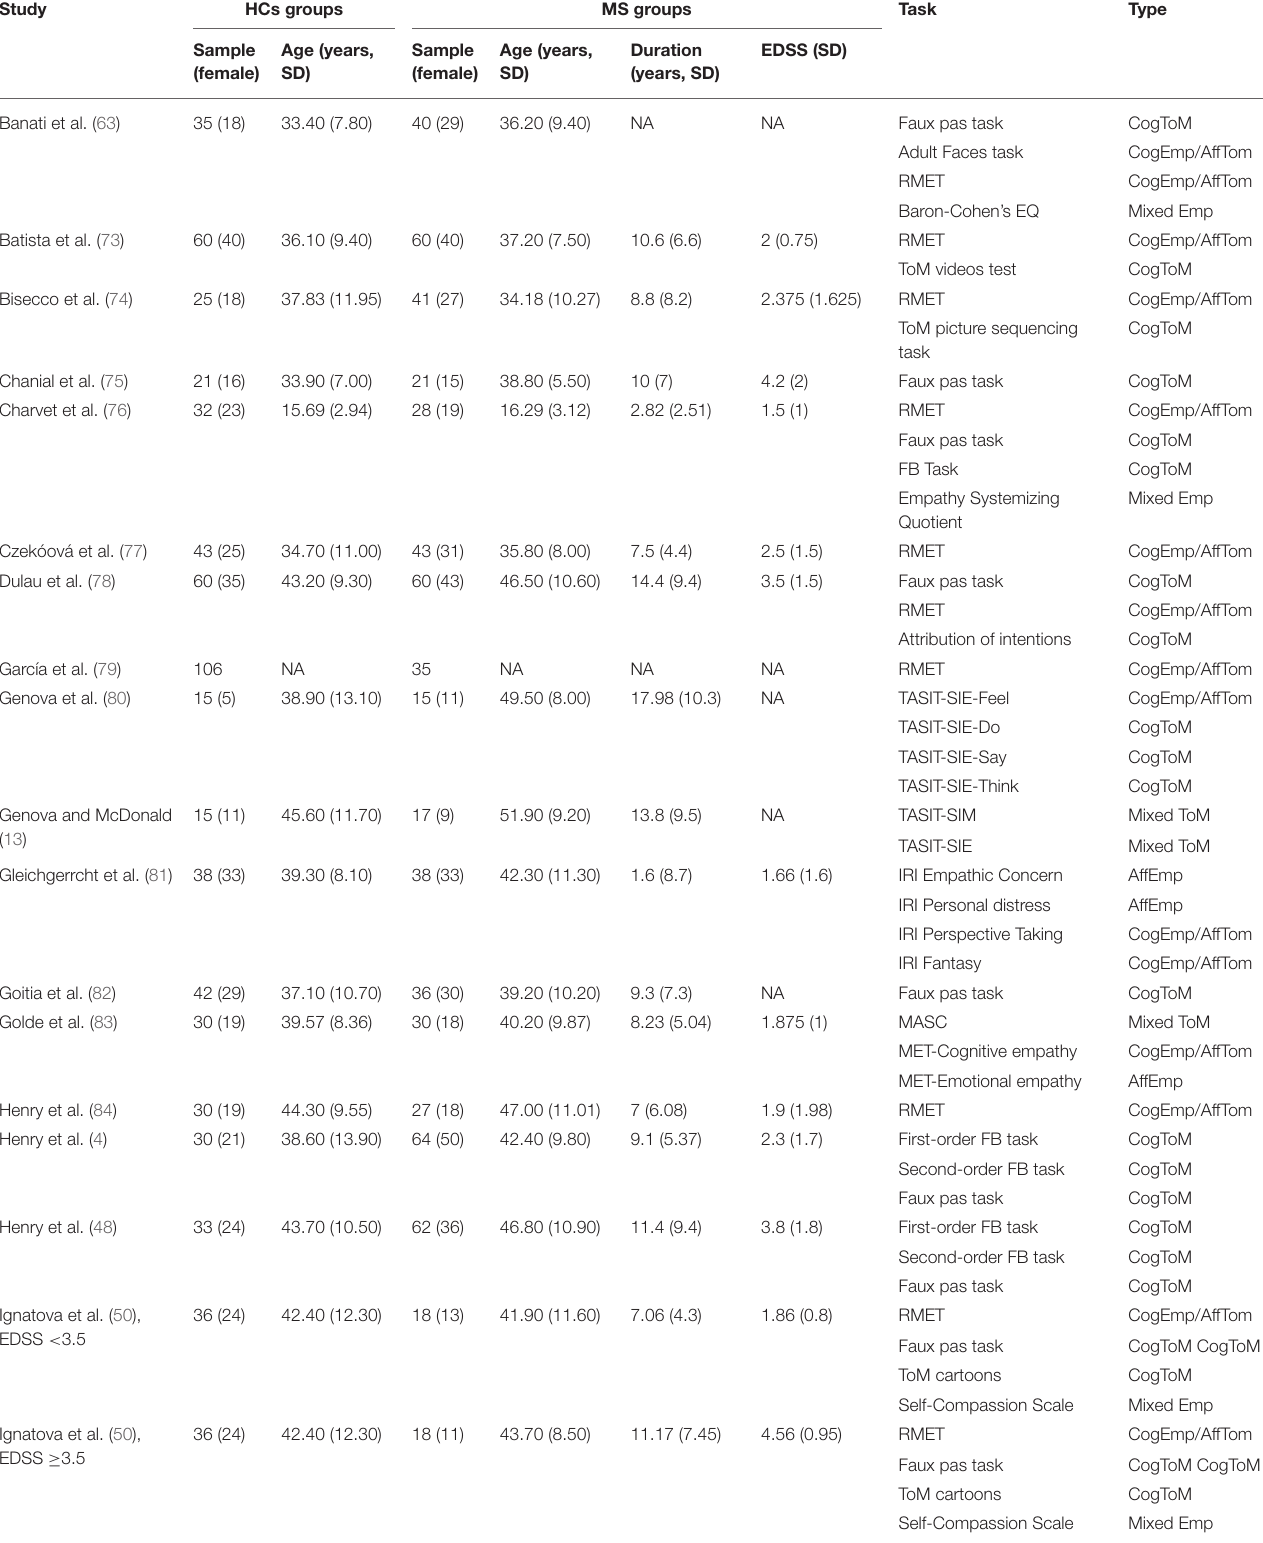
TABLE 1 | Individual study